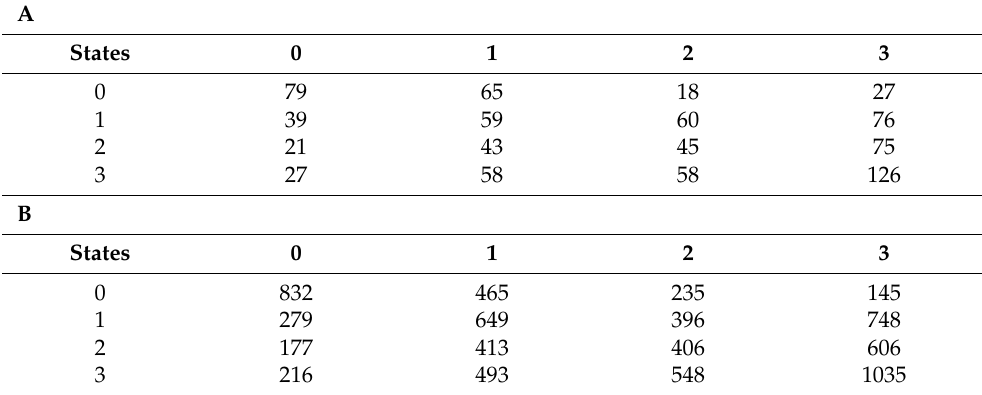
Table 4. A. Number of Mexican people with DM2 according to the transition matrix (2006–2018). B. Number of Mexican people without DM2 according to the transition matrix